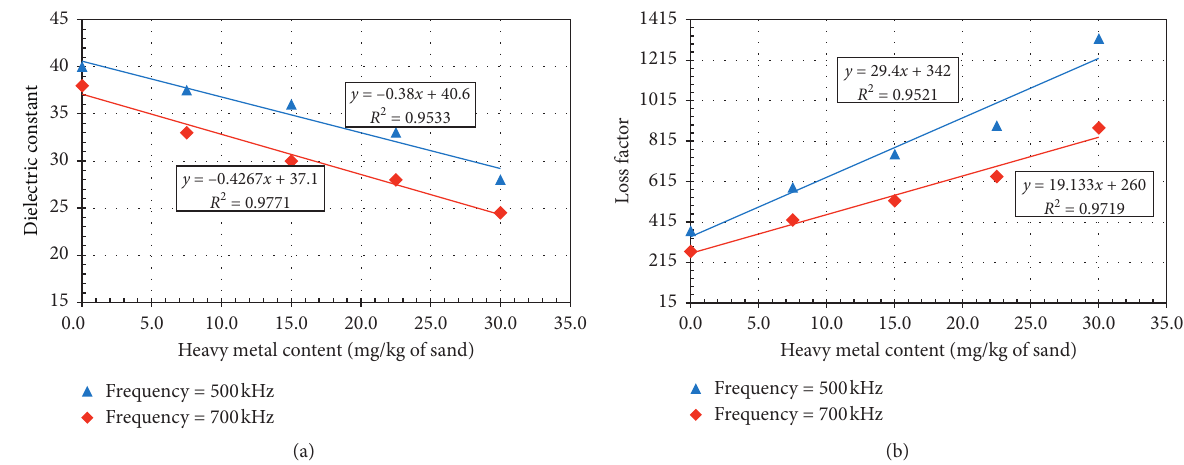
Figure 9: Regression analysis of complex permittivity and Fe content. (a) Dielectric constant versus Fe content. (b) Loss factor versus Fe